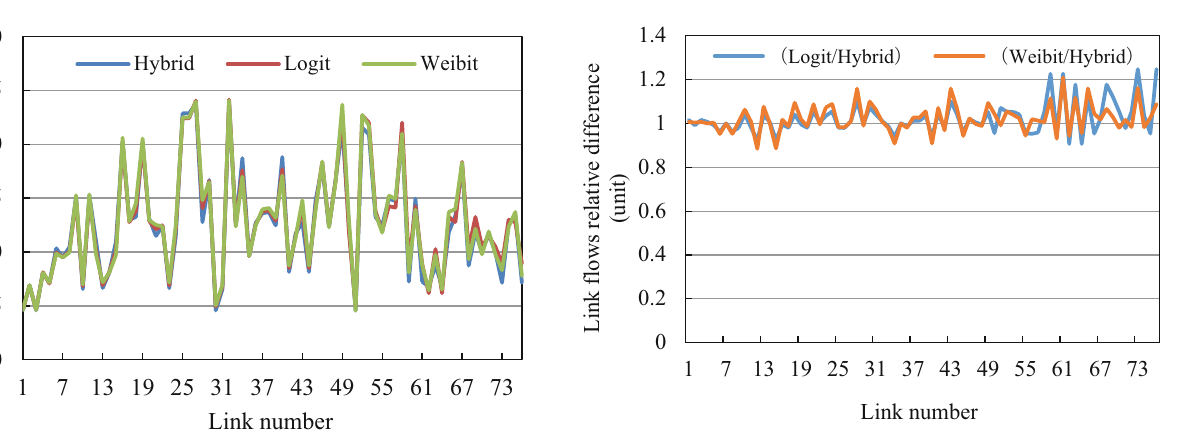
Fig. 7 Relative difference of link flows between logit/weibit and